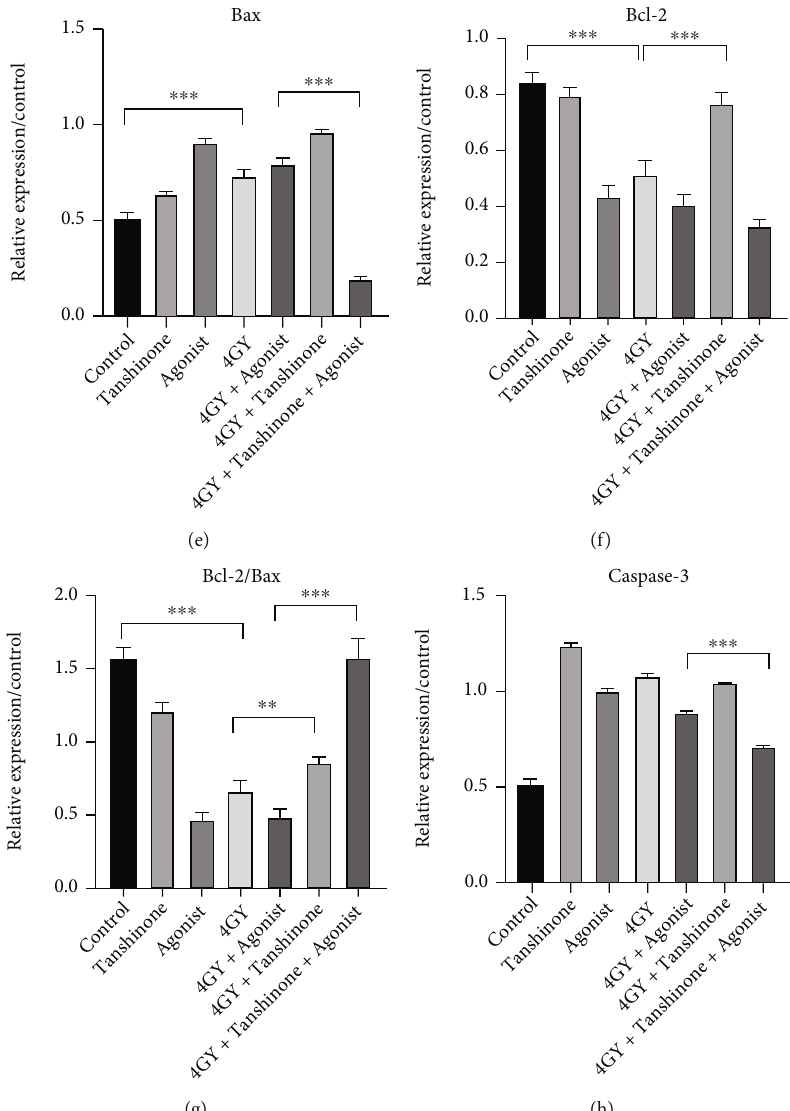
Figure 5: Expression of p38/p53 pathway related and apoptotic proteins. (a) It is a typical image of western blot. (b) P38 expression levels. (c) Ratio of p-p38/p38. (d) Ratio of p-p53/p53. (e) Bax expression levels. (f) Bcl-2 expression levels. (g) Ratio of Bcl-2/Bax. (h) Caspase-3 expression levels. GAPDH was used as reference. The results are expressed as mean ± SD . ∗∗∗ P < 0 : 001 and ∗∗ P < 0 : 01